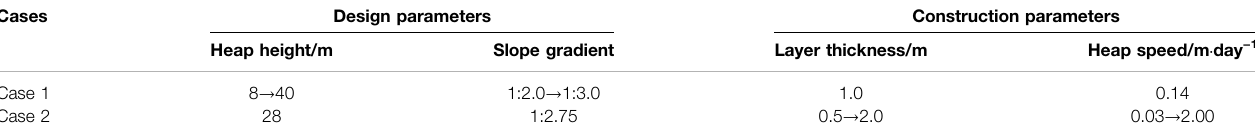
TABLE 2 | Designed cases in the fi nite-element simulations.